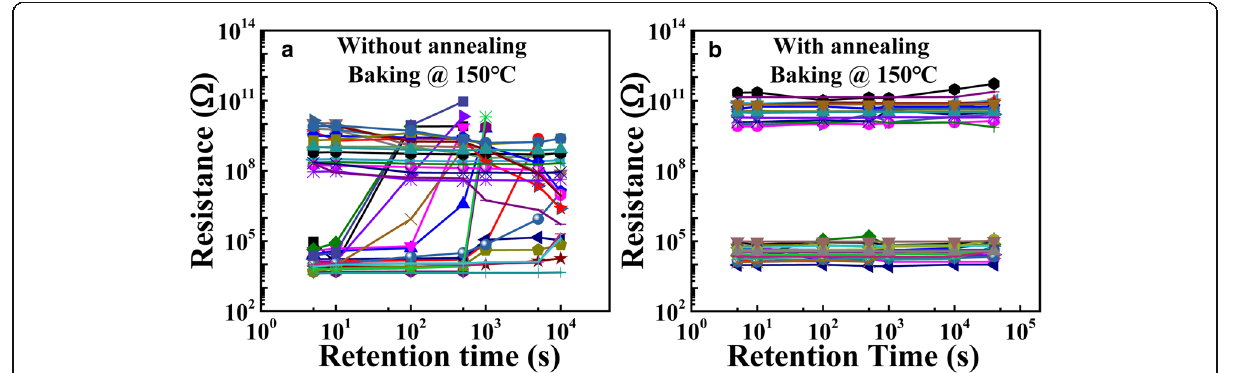
Fig. 5 Retention characteristics of the HRS/LRS for a un-annealed device and b annealed device at 150